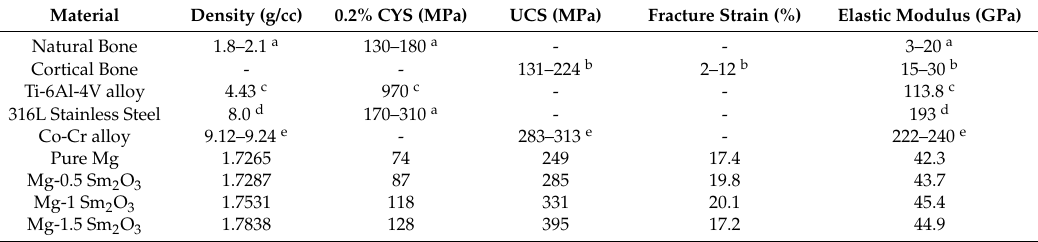
Table 6. Comparison between biomechanical properties of Mg–Sm 2 O 3 nanocomposites with Ti-6Al-4V alloy, 316L stainless steel, Co-Cr alloy, and hard and soft tissues of the human